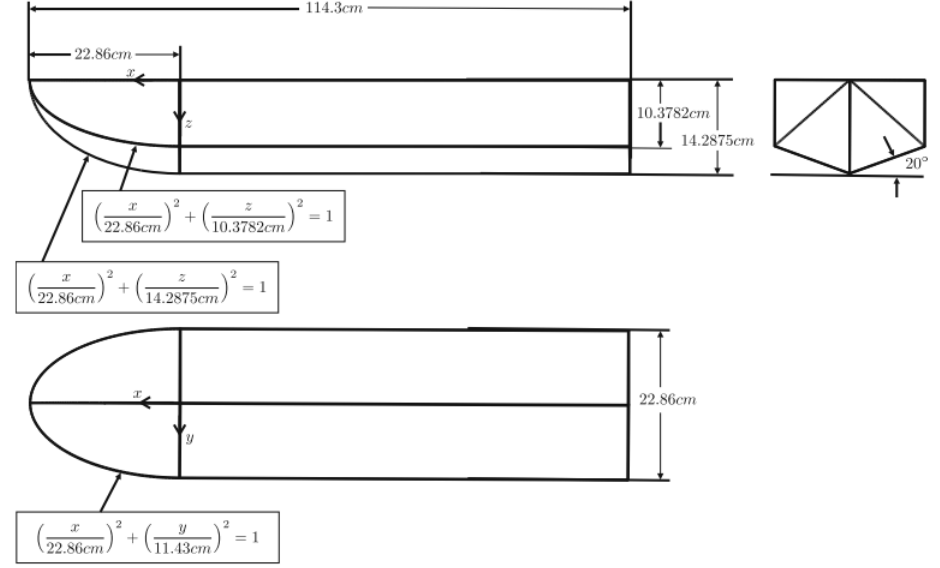
Figure 1. Fridsma hull form [7].